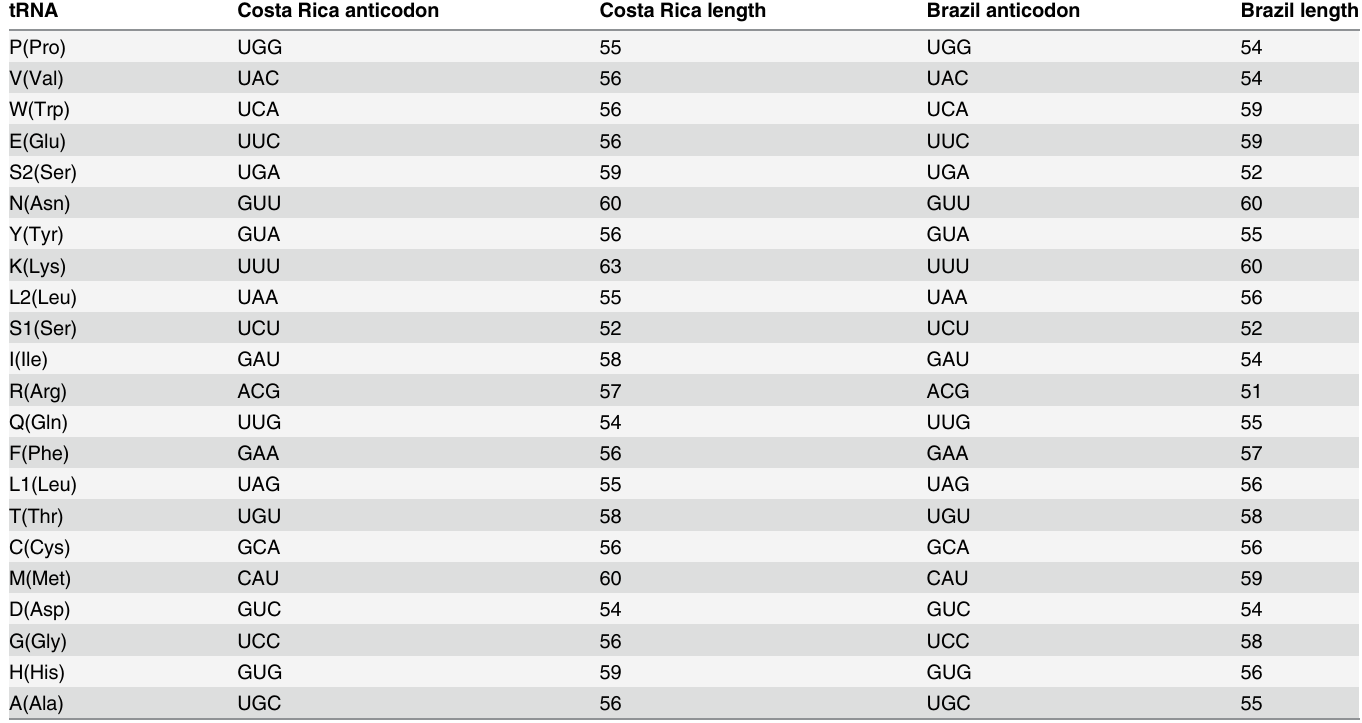
Table 6. Anticodon and length of tRNAs of Costa Rica and Brazil (NC_013067) taxa of Angiostrongylus costaricensis . W(Trp) had UCA anticodon (opal nonsense suppressor) instead of canonical CCA anticodon. tRNA Costa Rica anticodon Costa Rica length Brazil anticodon Brazil length 55 UGG 54 56 54 56